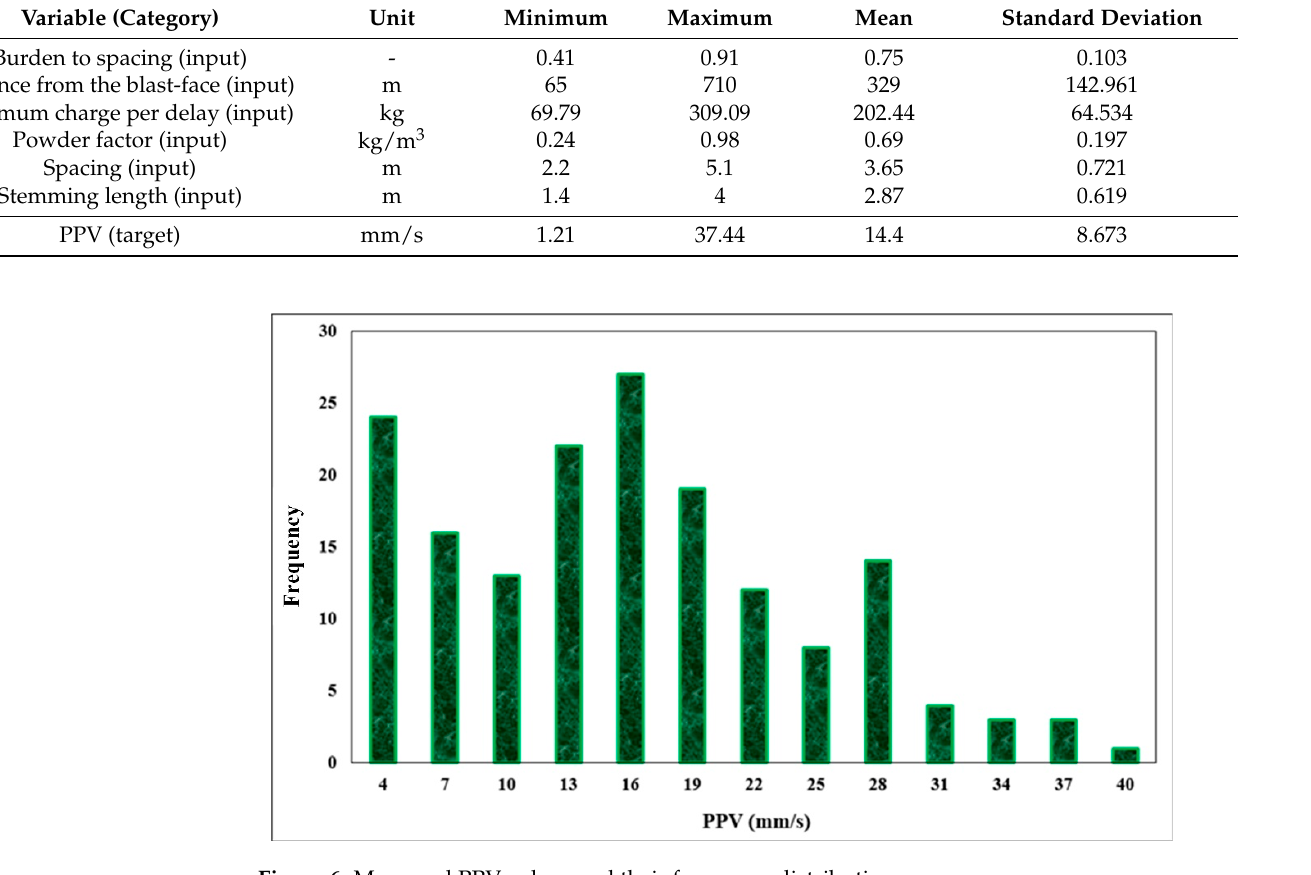
Figure 6. Measured PPV values and their frequency